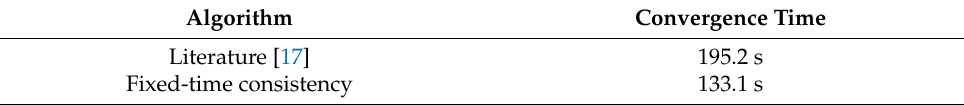
Figure 16. The rate of micro-increase. ( a ) The rate of micro-increase in fixed-time consistency at the random delay; ( b ) The rate of the Classical consensus algorithm at the random delay. Table 5. Demand load PD = 1500 MW, Total iteration time t = 300 s.